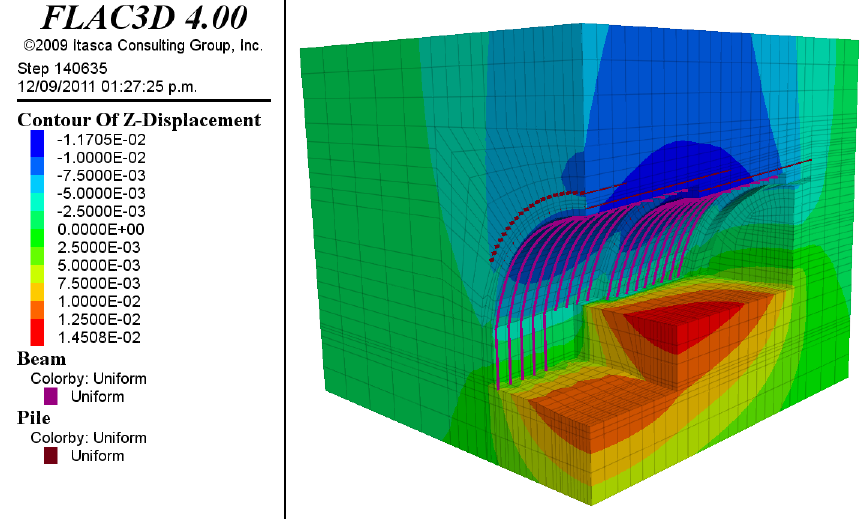
Figure 19. Vertical displacements (Uz in meters) in an intermediate stage of excavation. minimum parameters.